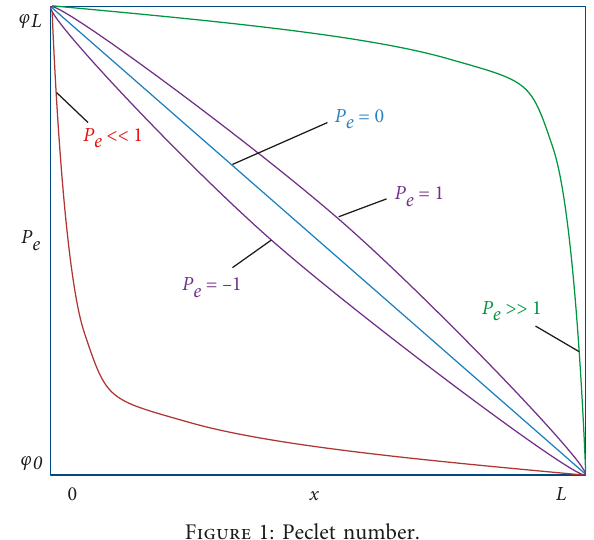
Figure 1: Peclet